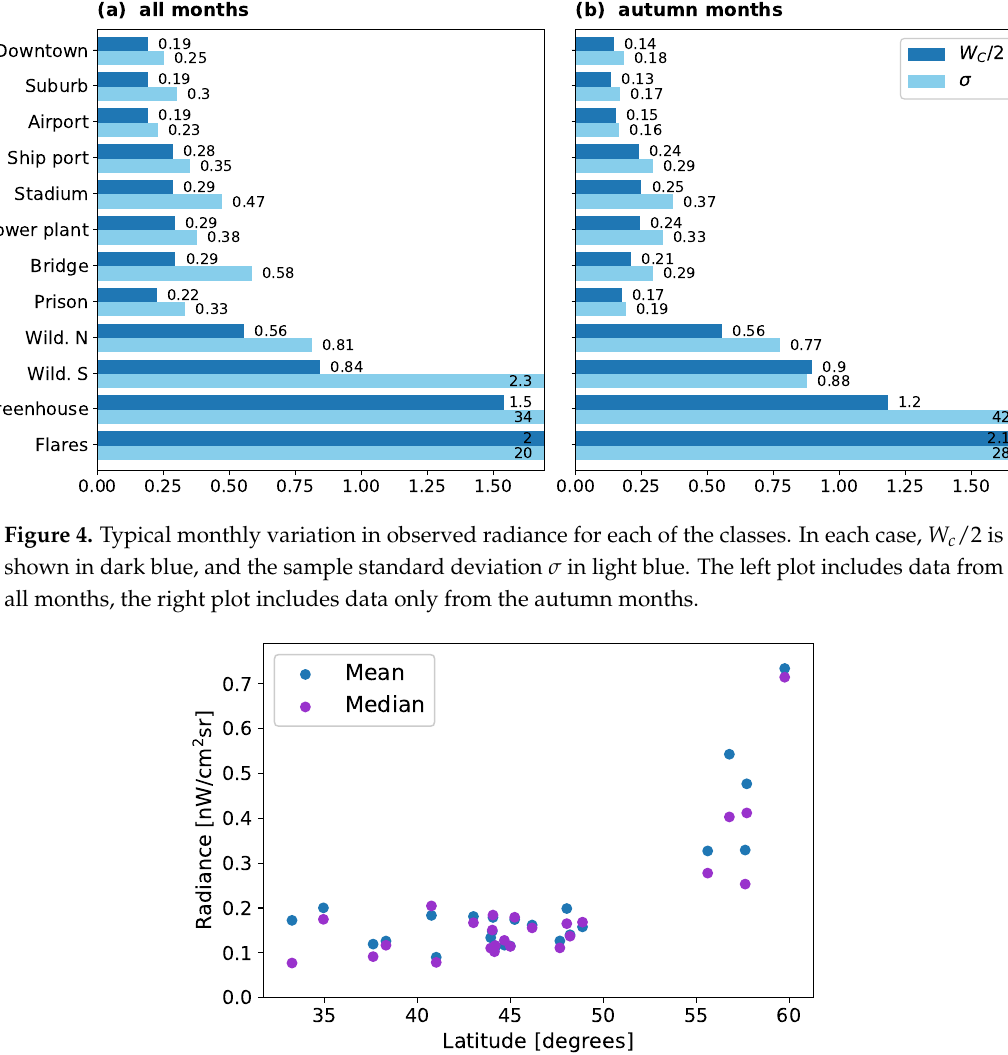
Figure 5. Scatterplot of average radiance of pixels in wilderness areas against latitude. Both the mean and median are shown. The wilderness areas in Alaska are more brightly lit on average, presumably due to auroral